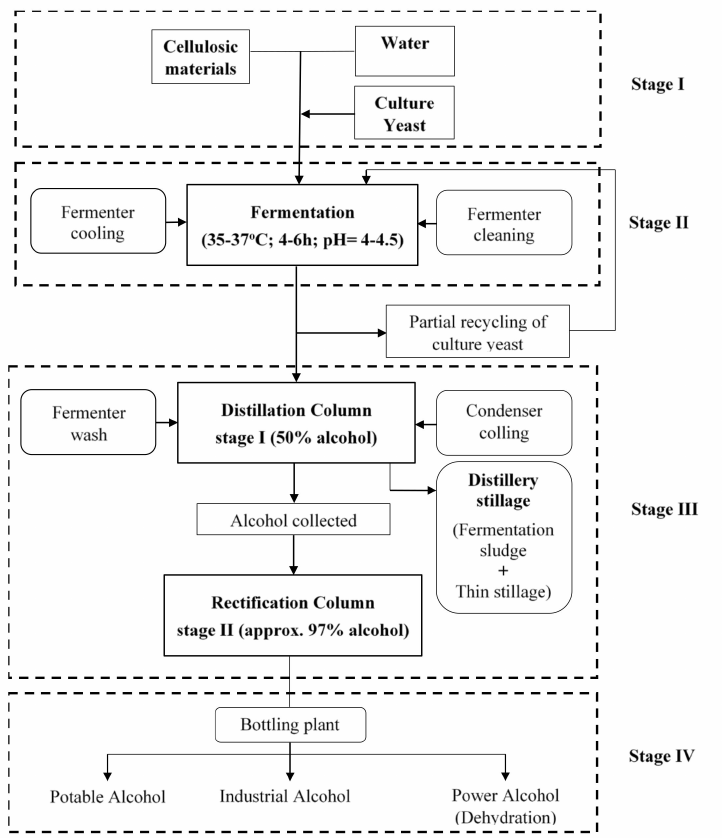
Figure 1. Alcohol production (stage I: feed preparation; stage II: fermentation; stage III: distillation; stage IV: